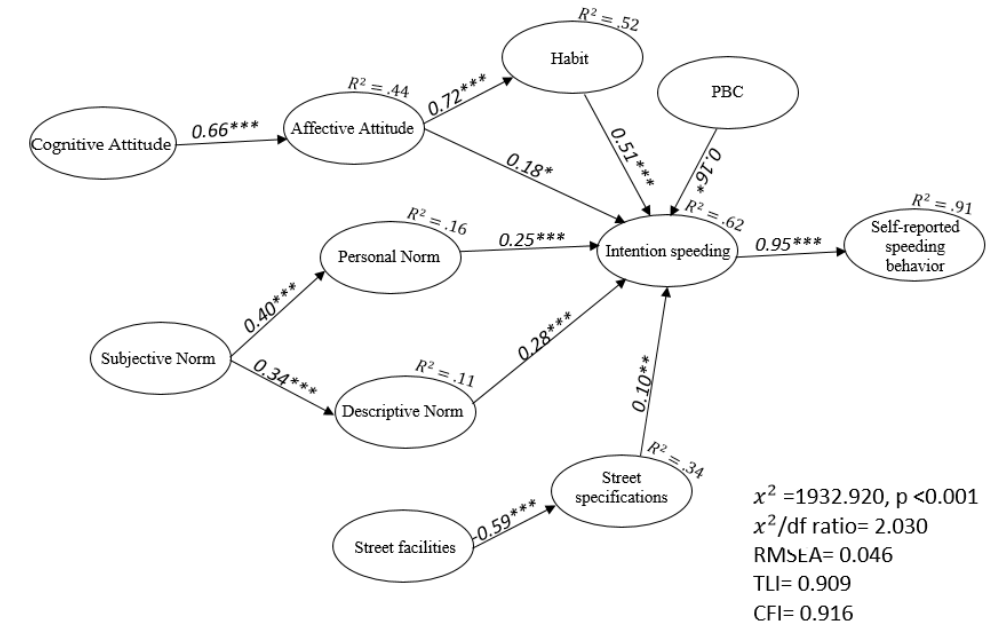
Figure 1. Speeding behavior model in reduced form. * p < 0.05; ** p < 0.01; *** p < 0.001.